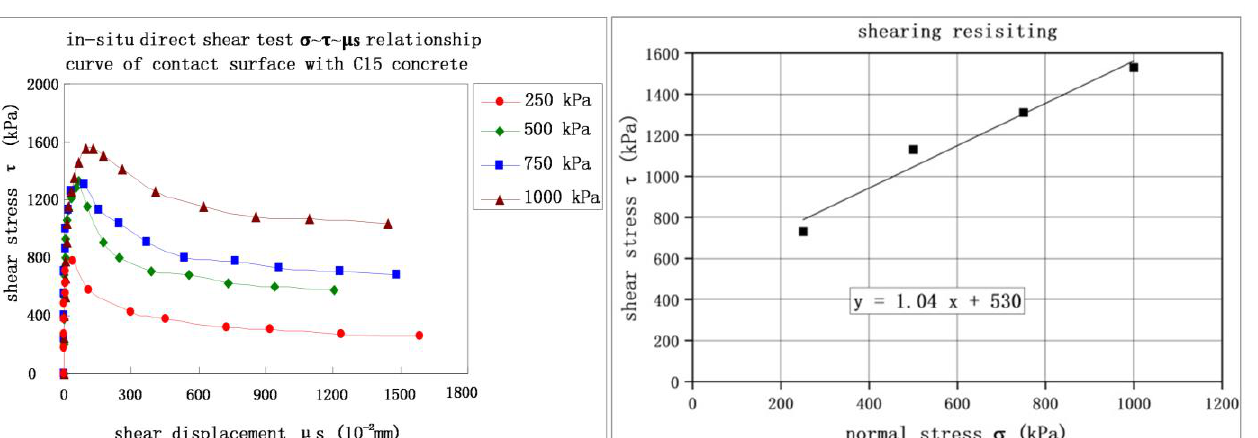
( d ) Figure 3. The typical failure of the shear piers: ( a ) soft sandstone contents of 50% between the bulk alone; ( b ) soft sandstone contents of 60% between the bulk alone; ( c ) soft sandstone contents of 70% between the bulk alone; and ( d ) soft sandstone contents of 60% between the bulk and the concrete interface.